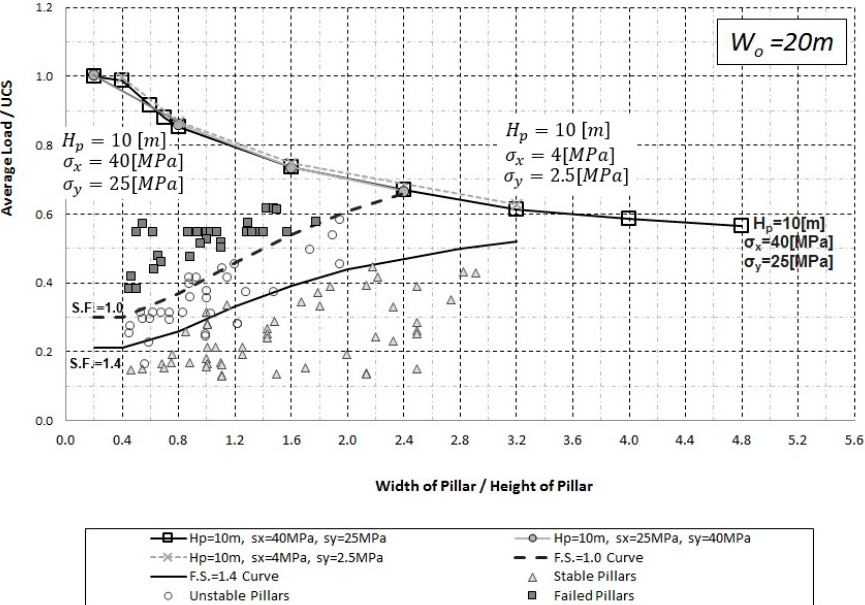
Figure 11. Empirical stability chart and modeling results—failure envelopes for different far field stresses σ h , σ v .